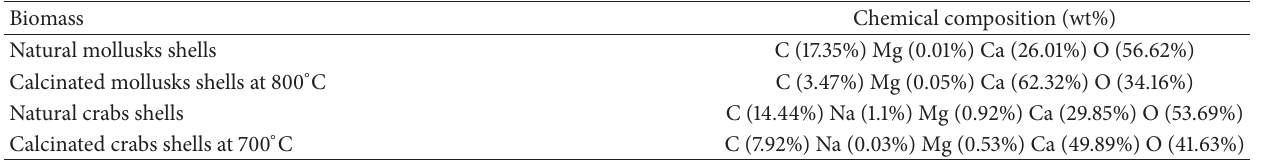
Table 2: Chemical composition of biomass derived